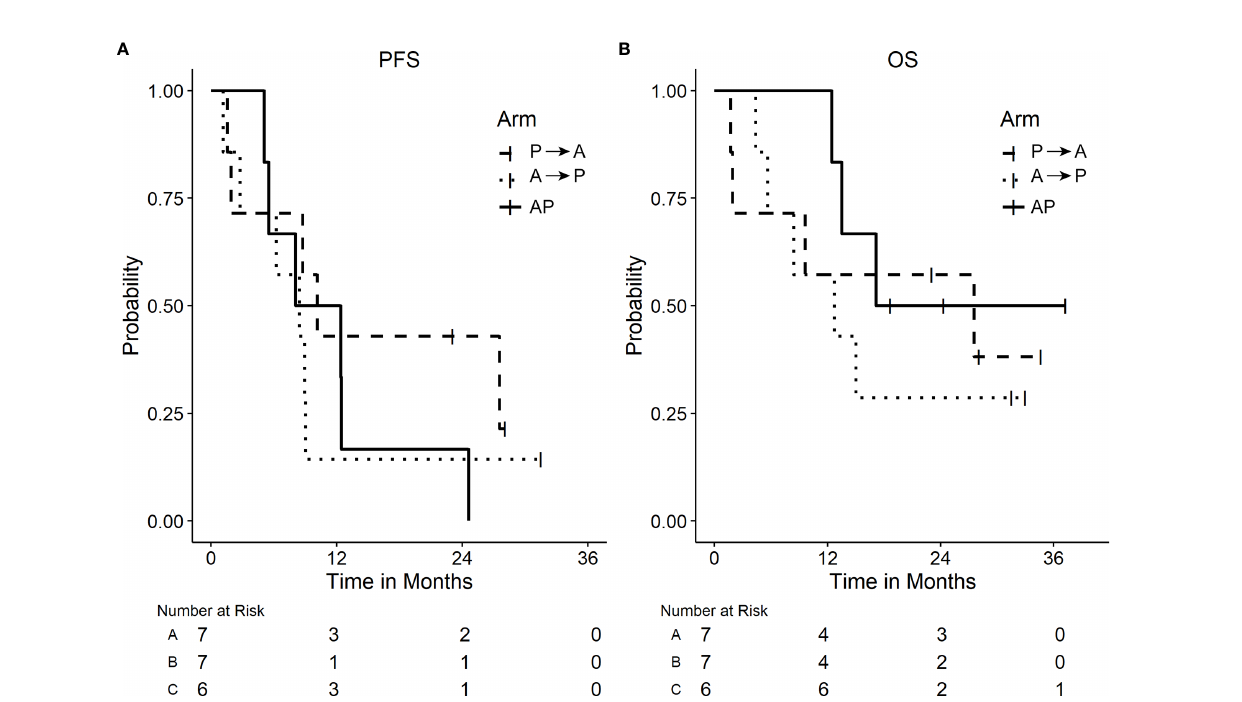
FIGURE 2 | Plots of Kaplan Meier Survival curves. (A) Progression-free survival (PFS). (B) Overall survival (OS) by arm.